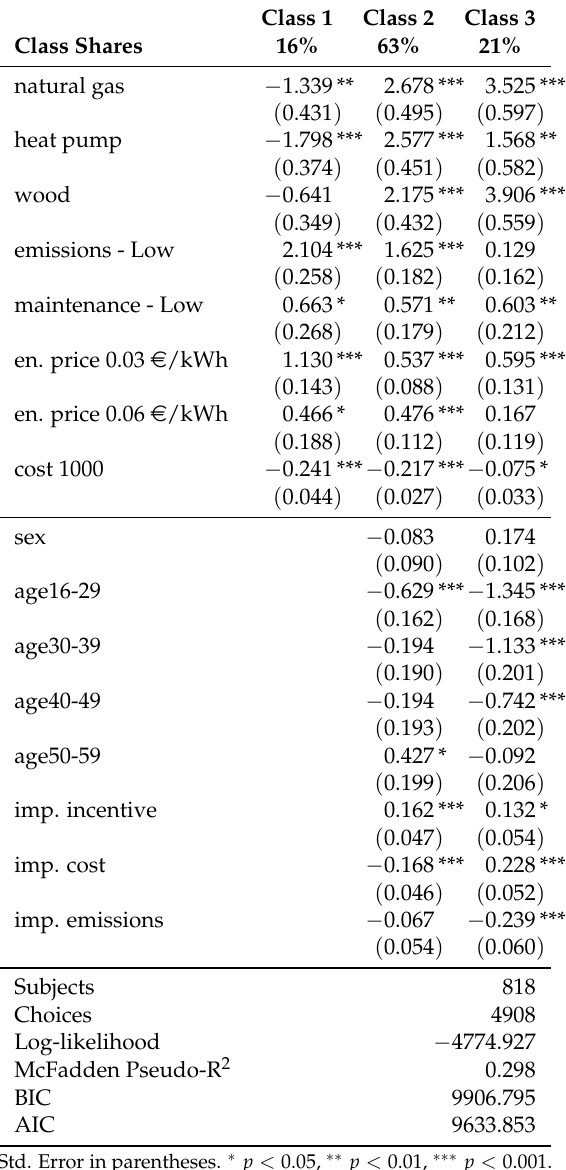
Table 5. Latent Class model